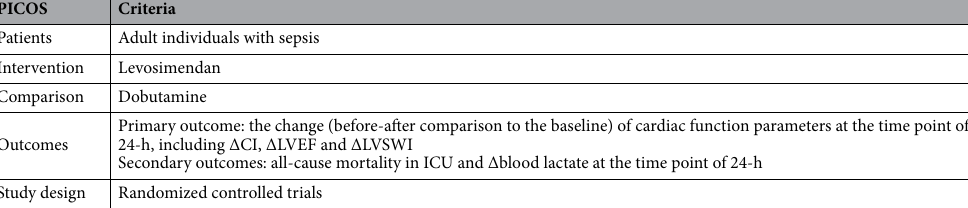
Table 1. PICOS approach for selecting clinical studies in the systematic search. CI cardiac index; LVEF left ventricular ejection fractions; LVSWI left ventricular stroke work index; ICU intensive care